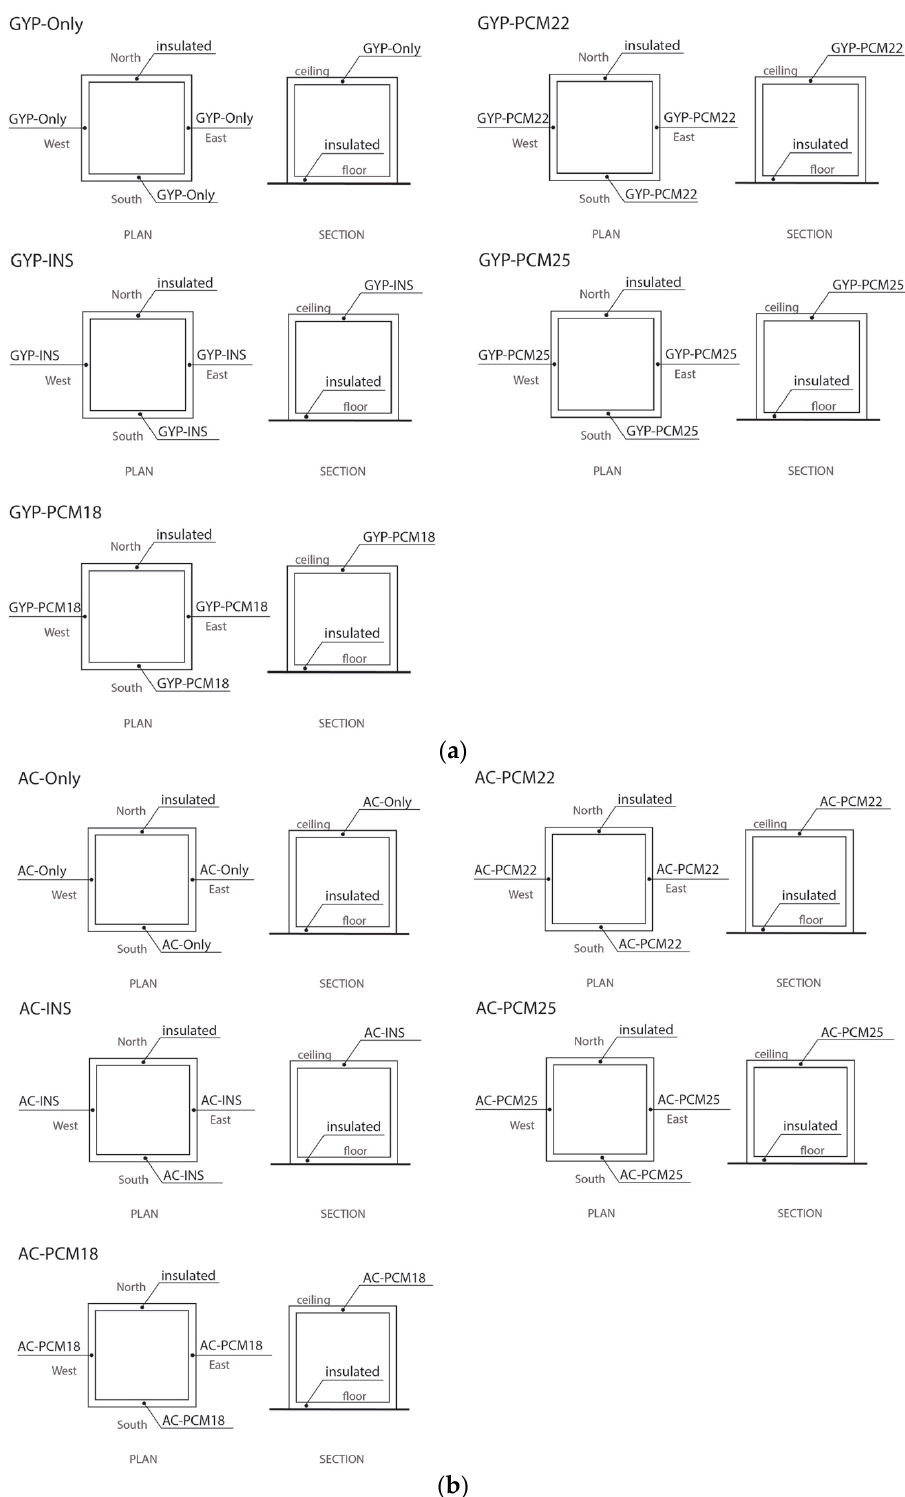
Figure 4. ( a ) Envelope construction systems corresponding to the GYP group. ( b ) Envelope construction systems corresponding to the AC group.